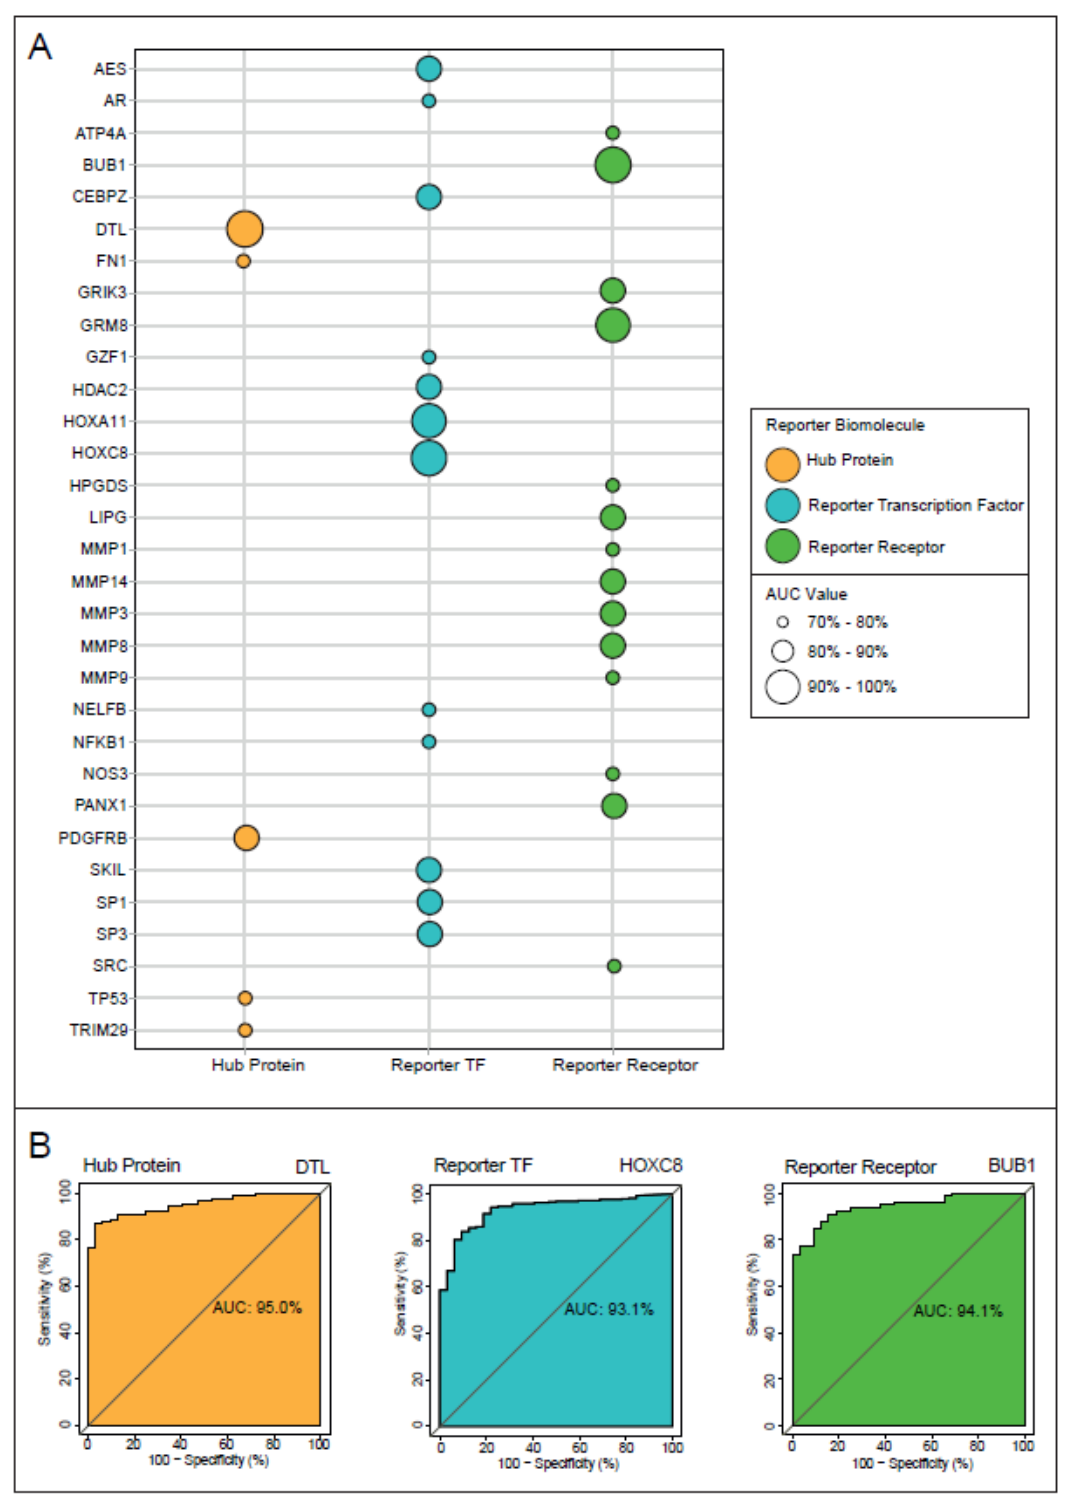
Figure 4. The diagnostic performance analyses of the reporter biomolecules. ( A ) The bubble plot representing the AUC values of the reporter biomolecules. Only the AUC values that were considered significant in the study were shown (AUC > 70%). Hub proteins are shown in orange, reporter tran- scription factors (TFs) in blue, and reporter receptors in green. ( B ) The major reporter biomolecules: a hub protein, a TF, and a reporter receptor according to their AUC